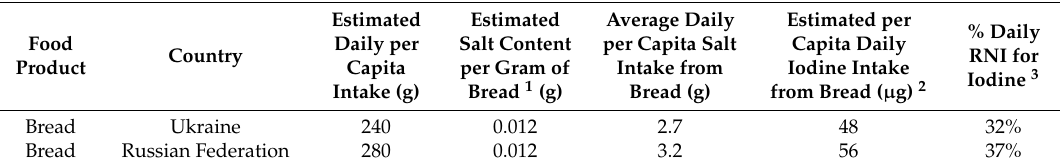
Table 5. Potential adult iodine intake from bread if all salt used in bread baking is iodised at the level of 25 mg/kg iodine, Ukraine and the Russian